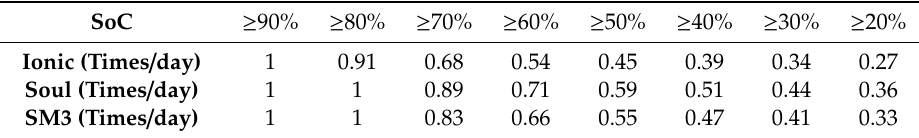
Table 15. The number of charging times per day “Based on SoC” type users charge their EVs.